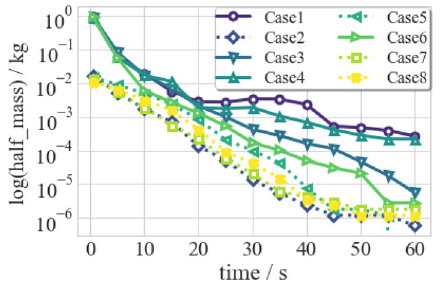
Figure 24. The total mass of droplets in the lower half of the classroom varies with time.